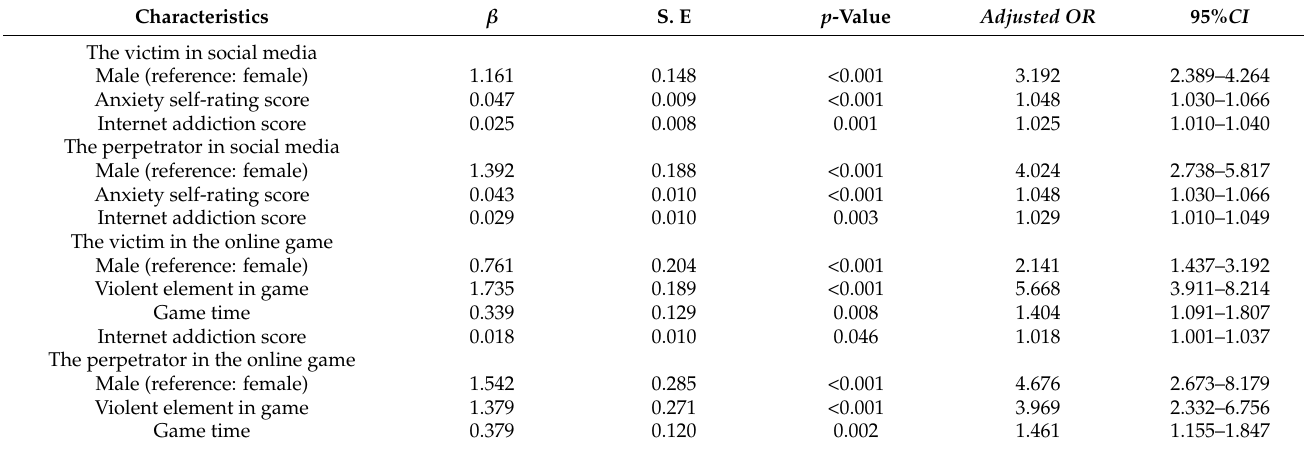
Table 5. Multivariate logistic regression analysis on associated factors of cyberbullying among College Students.